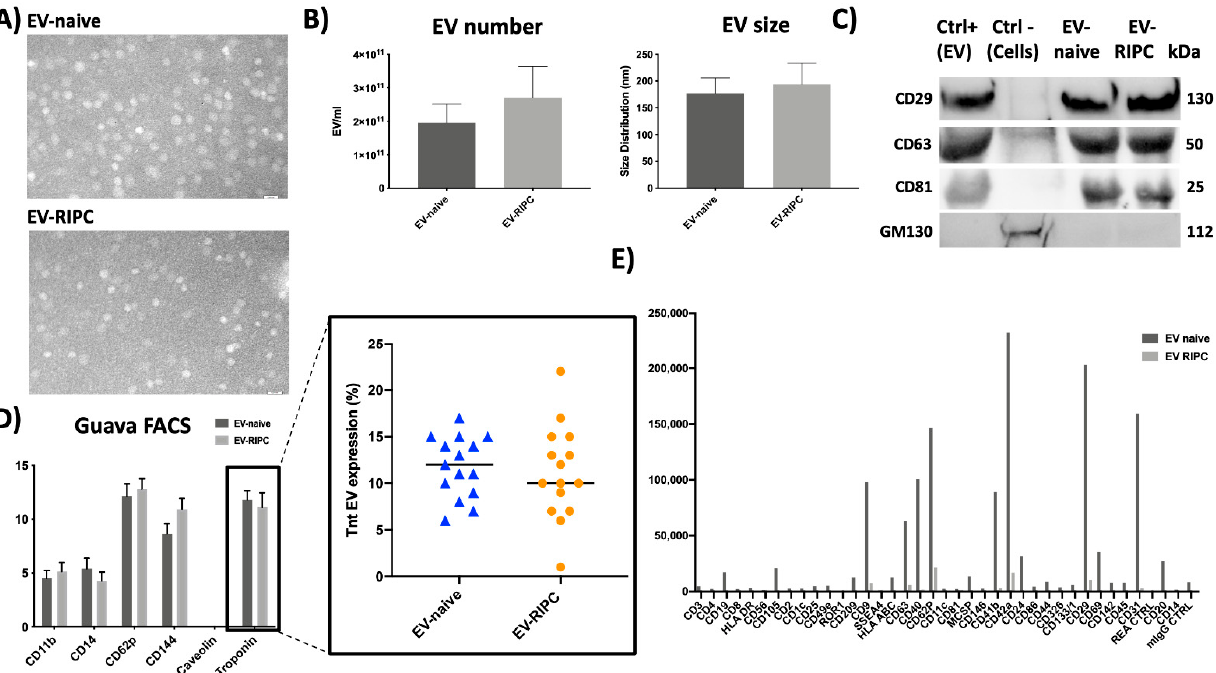
Figure 2. EV characterization. ( A ) Representative images of TEM performed on EV-naive and EV-RIPC (n = 3/each group). Original magnification 140 K, scale bar: 100 nm. ( B ) Histograms representing EV size and number. ( C ) Representative Western blot of exosome markers (CD29, CD63 and CD81) detected in serum-derived EVs (Ctrl+), EV-naive and EV-RIPC, and negative marker of EVs (GM130). ( D ) Flow cytometry with GUAVA FACS on EV-naive and EV-RIPC; the insert shows the EV TnT content (%) in all thirty patients. ( E ) FACS with MacsPlex kit on EV-naive and EV-RIPC.